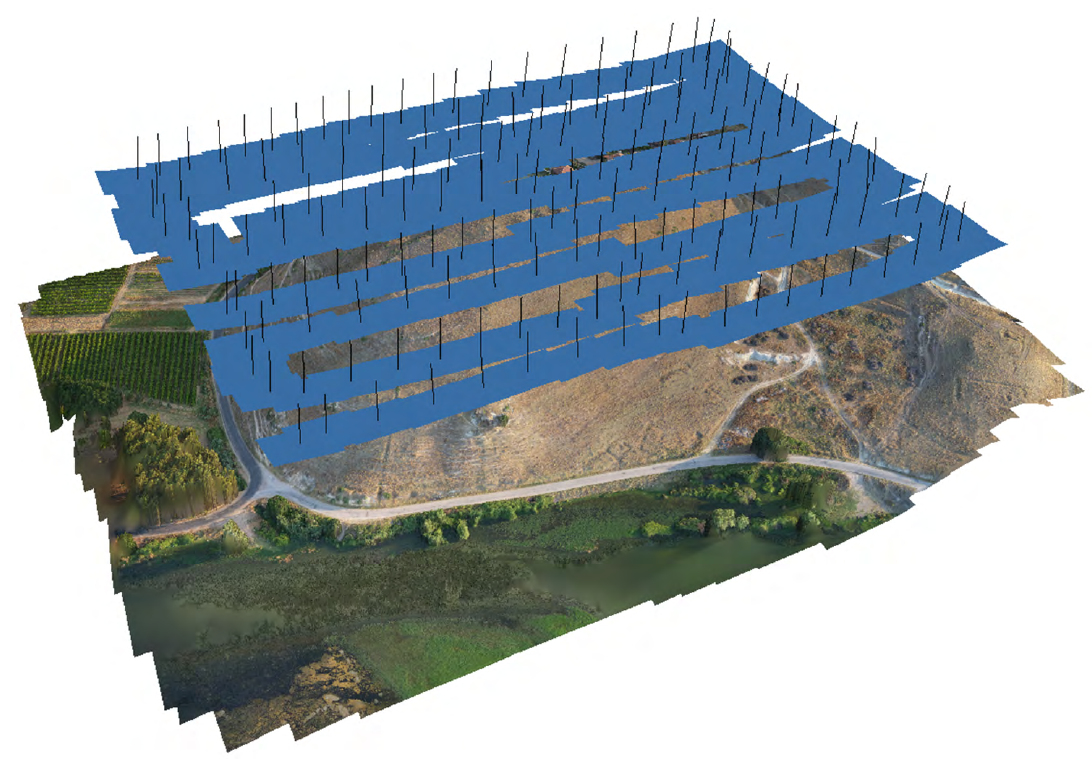
Figure 7: Perspective view of Asar Tepe 1, showing the camera positions associated with each aerial image and the resultant digital surface model (here textured with the aerial photos